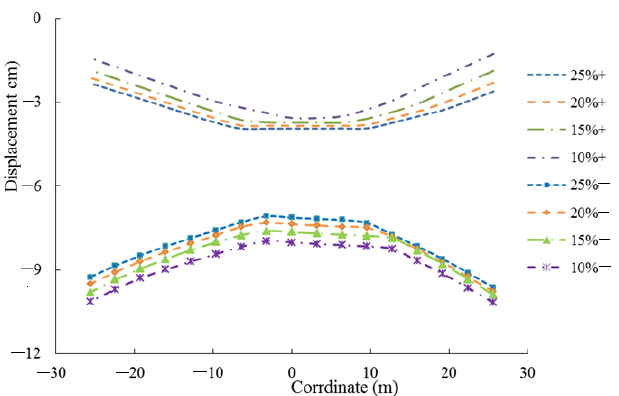
Figure 16. Comparison of the peak vertical displacement response of the 3D-CIBs.